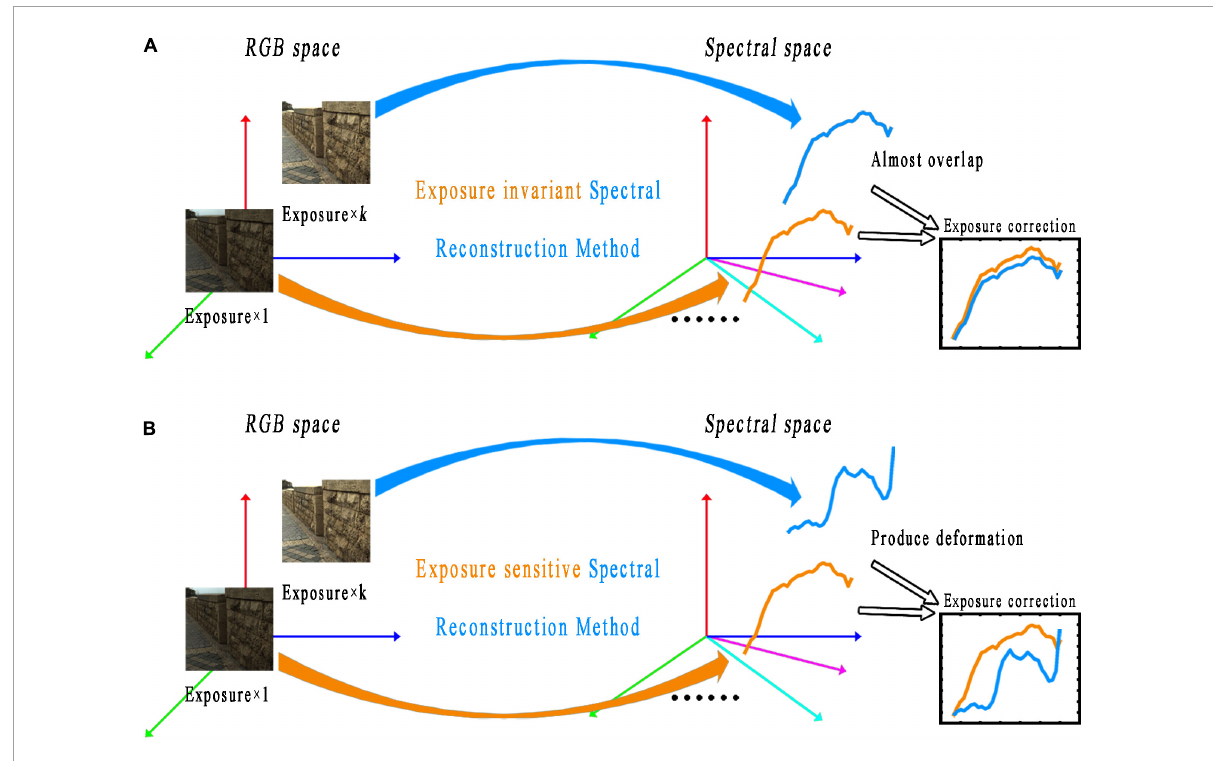
FIGURE1 Schematic diagram of the exposure invariant (A) and exposure sensitive (B) spectral reconstruction methods. The photos appearing in these figures are chosen from the public multispectral dataset from the NTIRE challenges